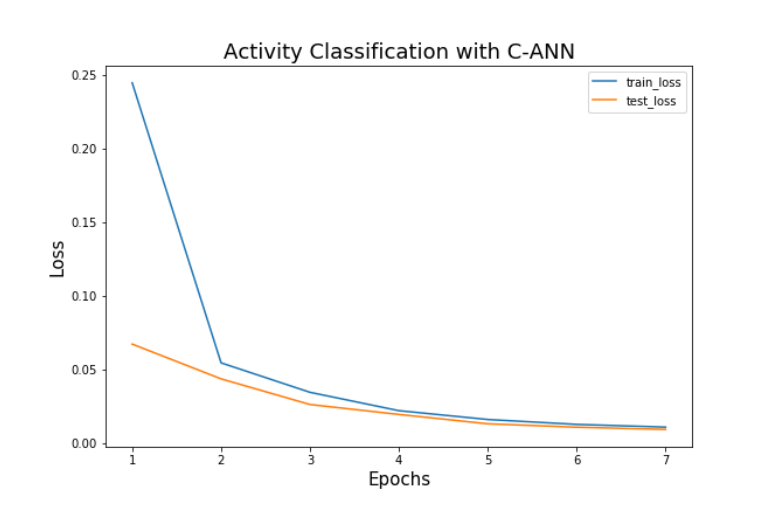
Figure 15. Training and testing losses of C-ANN Model.